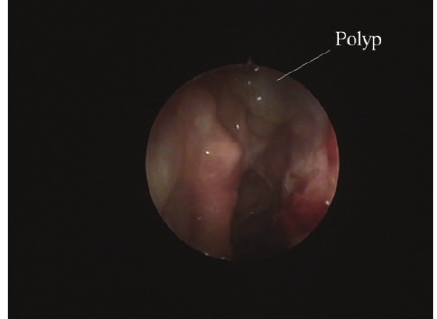
Figure 1: Right nostril. Day 8. Early eruption of polyps.